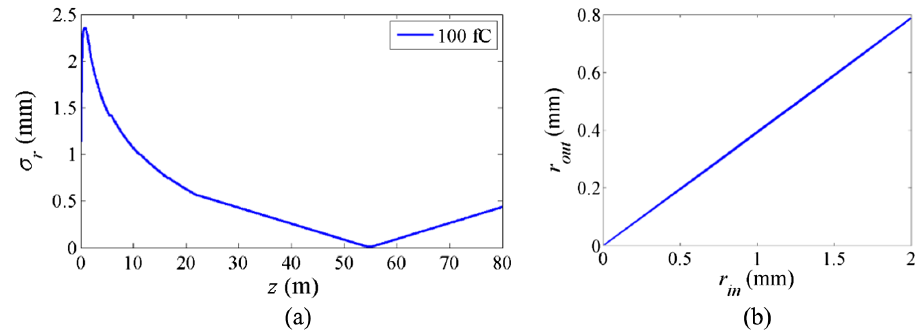
FIG. 6. (a) rms beam radius σ r as a function of the longitudinal position z for a 100-fC beam in the proposed 23-m beam line in Fig. 5. The solenoid coils focus the beam at z ∼ 55 m. The rms beam radius is kept under 200 μ m between z ¼ 45 to 65 m for, say, a radiation insertion device. (b) Linear relationship found from simulation between the input and output radial positions r z ¼ 23 m, the position of the accelerator exit) of the electrons for the 100-fC